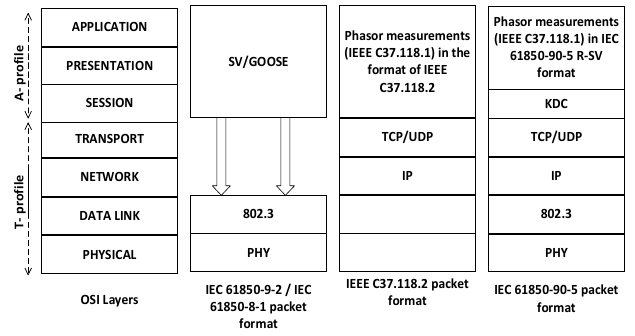
Figure 4. Comparison of IEEE C37.118.2 and IEC 61850-90-5 with GDOI.